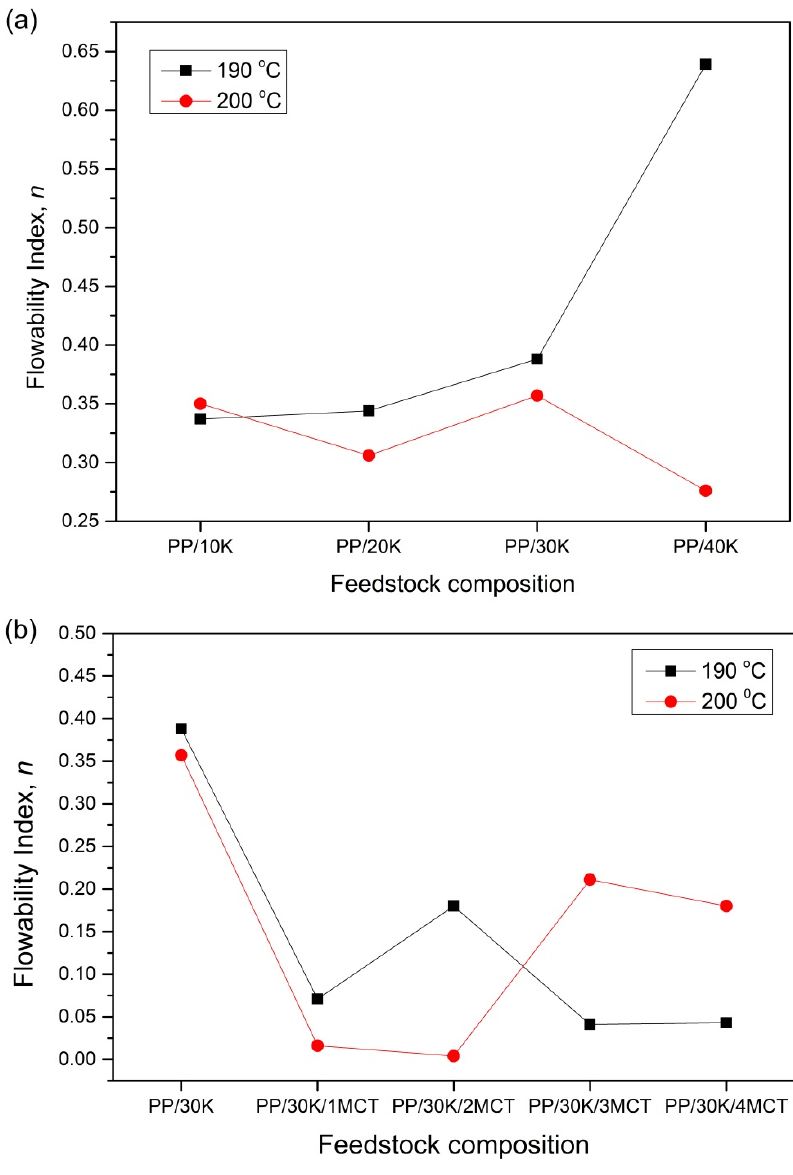
Figure 3. Flowability index of ( a ) PP / kenaf and ( b ) PP / kenaf / MWCNT composites at different Figure 3 . Flowability index of ( a ) PP/kenaf and ( b ) PP/kenaf/MWCNT composites at different temperatures .